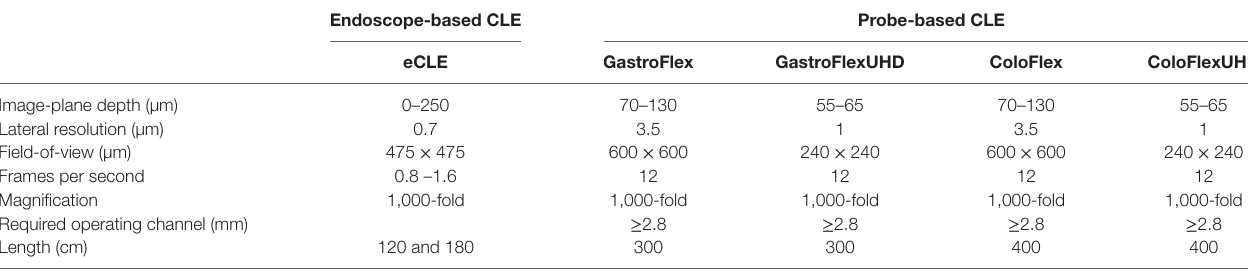
TABLe 1 | Technical characteristics of probe based and endoscope-based CLE